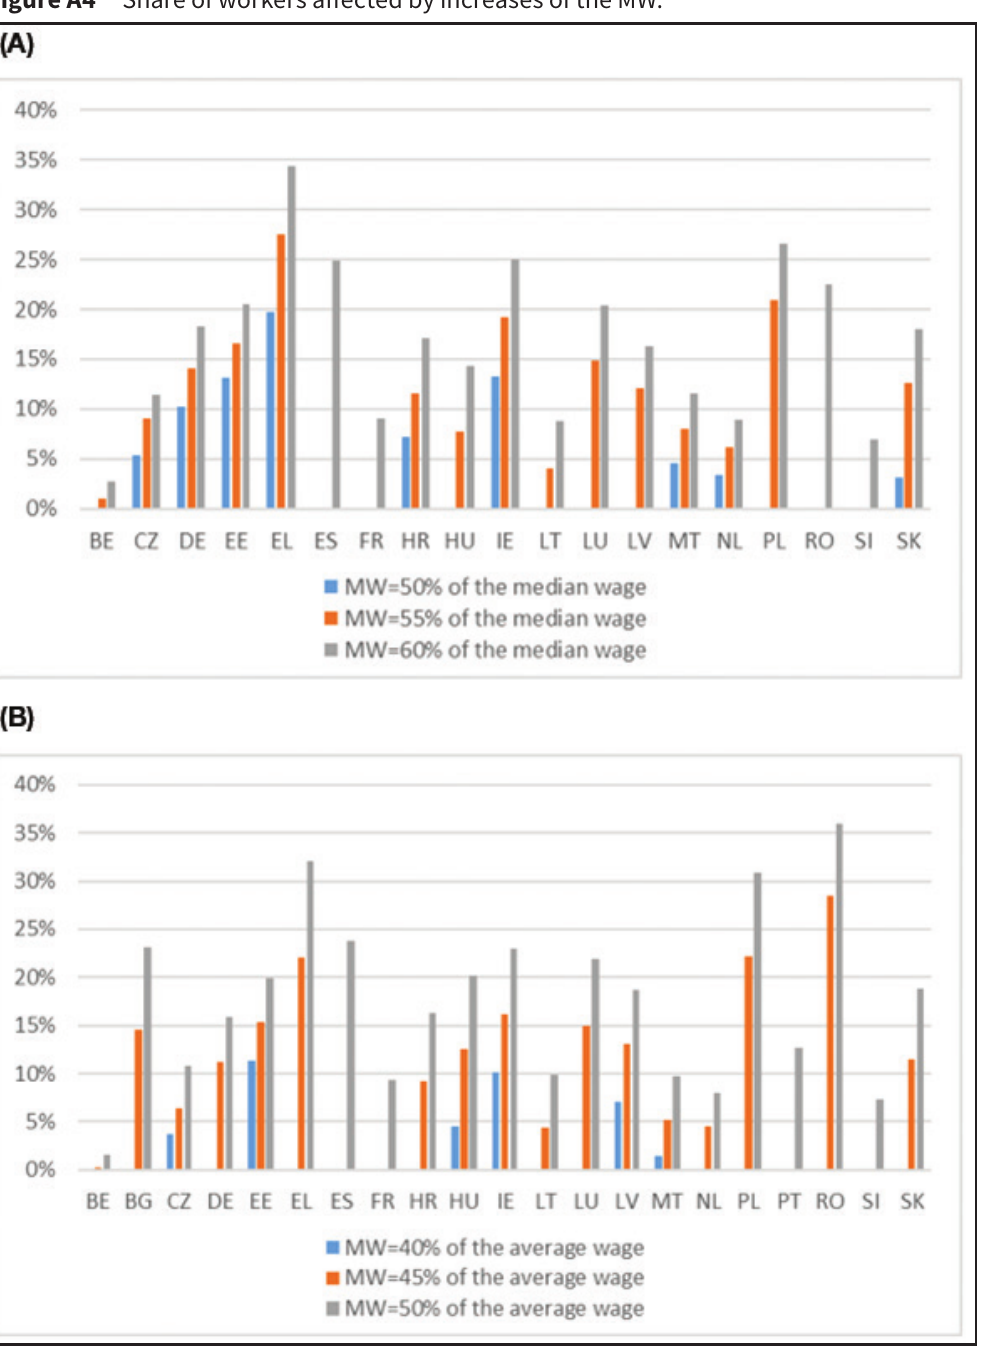
Figure A4 Share of workers affected by increases of the